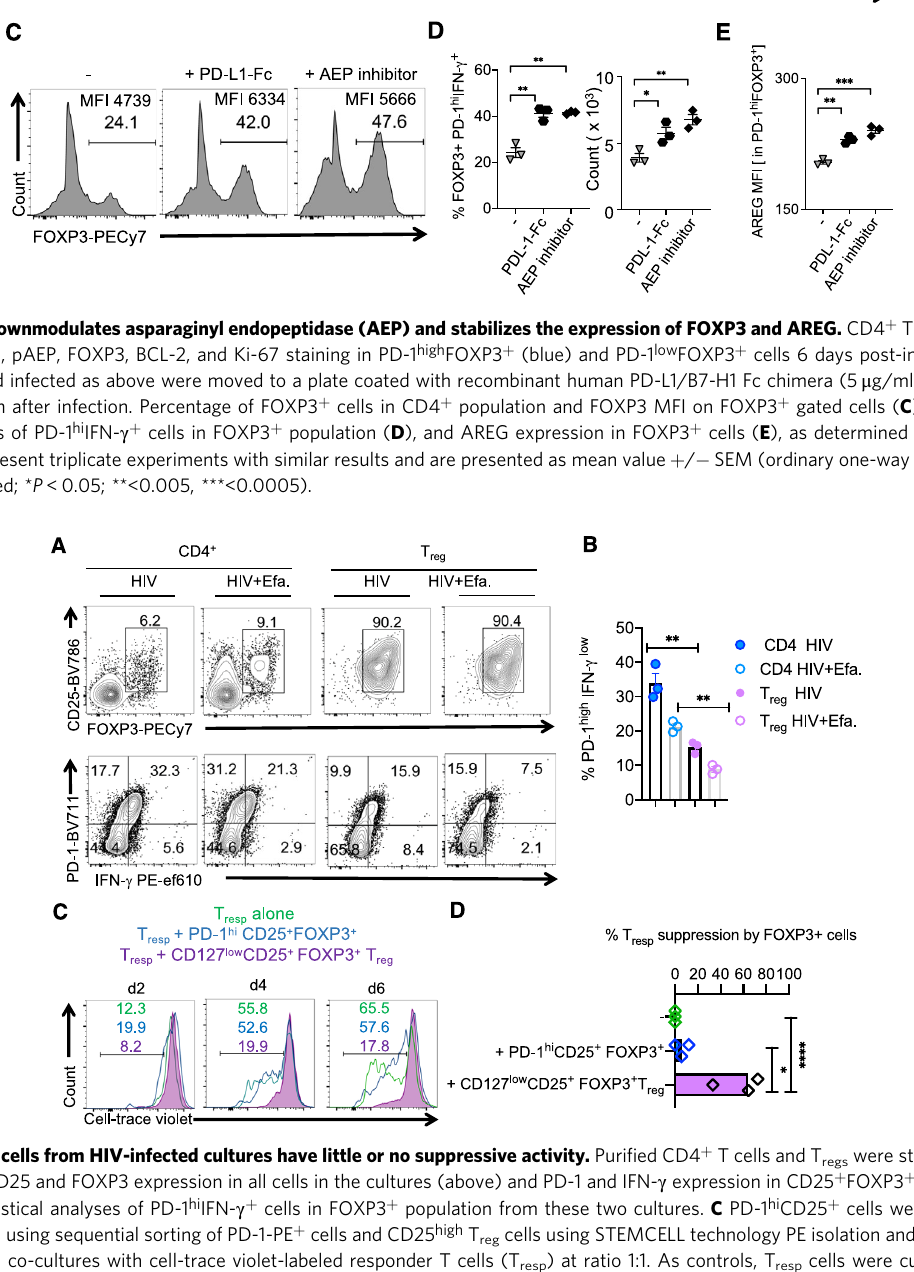
NATURE COMMUNICATIONS| (2021) 12:5143